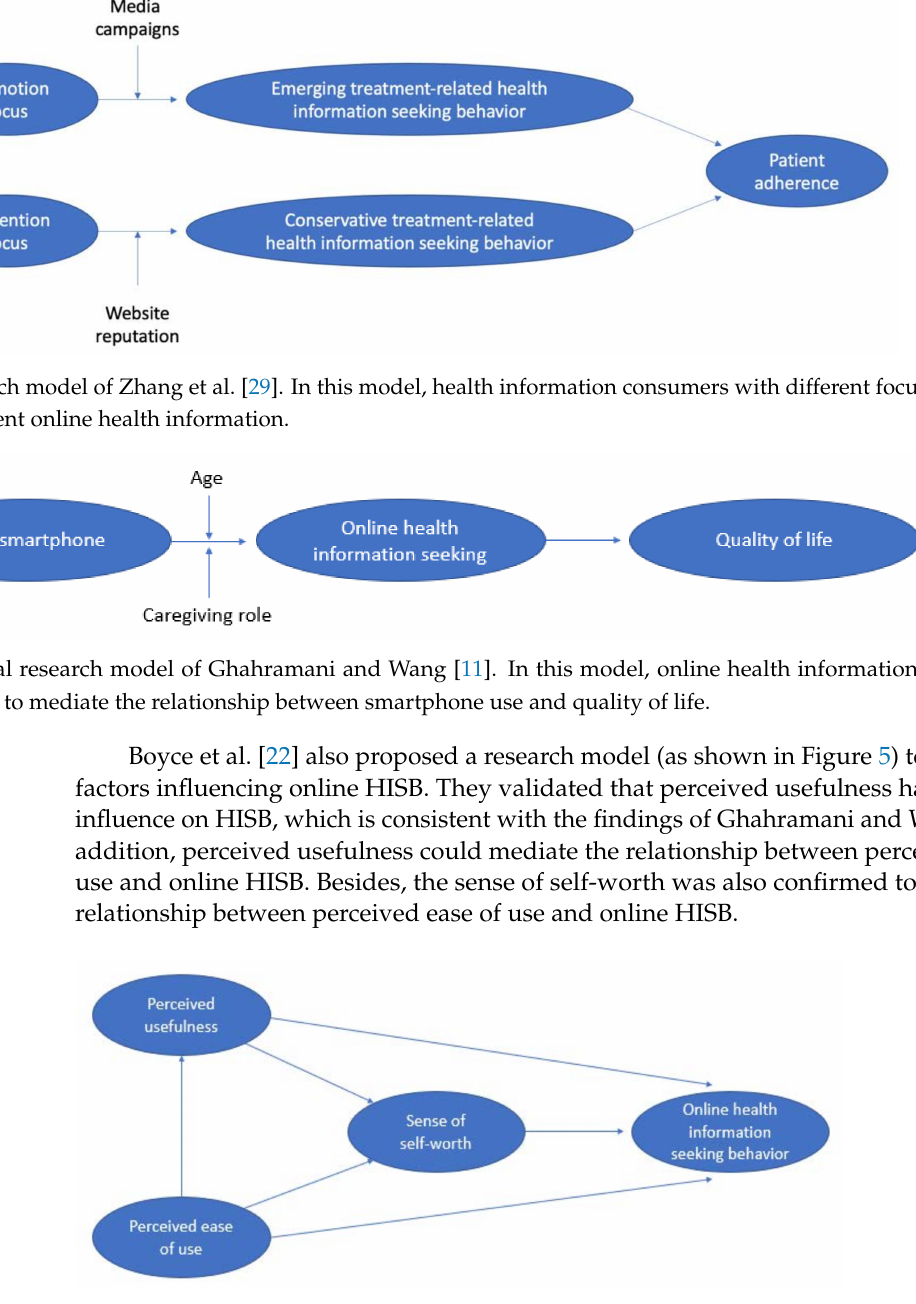
Figure 5. The research model of Boyce et al. [22]. In this model, online health information seeking behavior was found to be influenced by perceived usefulness, perceived ease of use and sense of